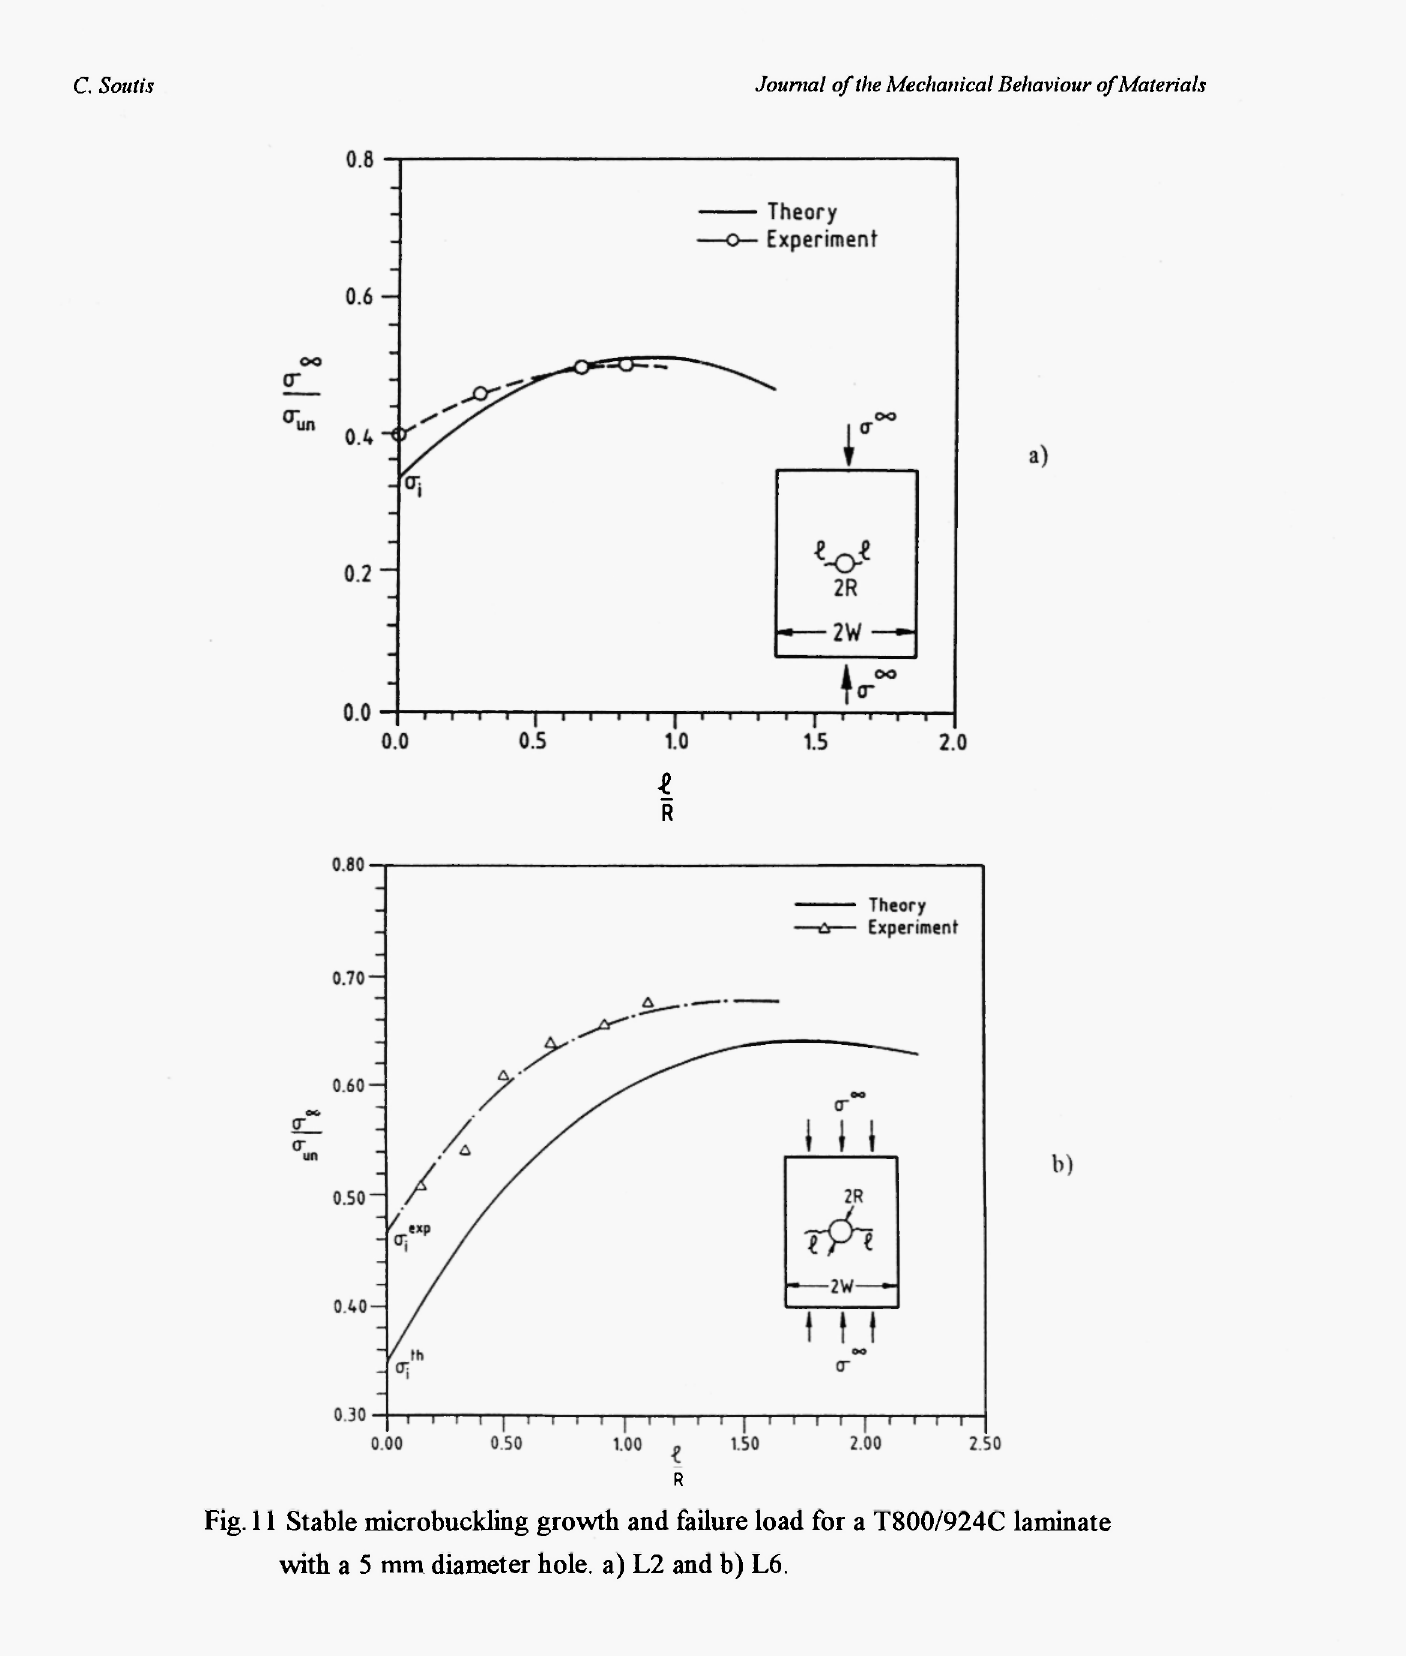
Fig. 11 Stable microbuckling growth and failure load for a T800/924C laminate with a 5 mm diameter hole, a) L2 and b)